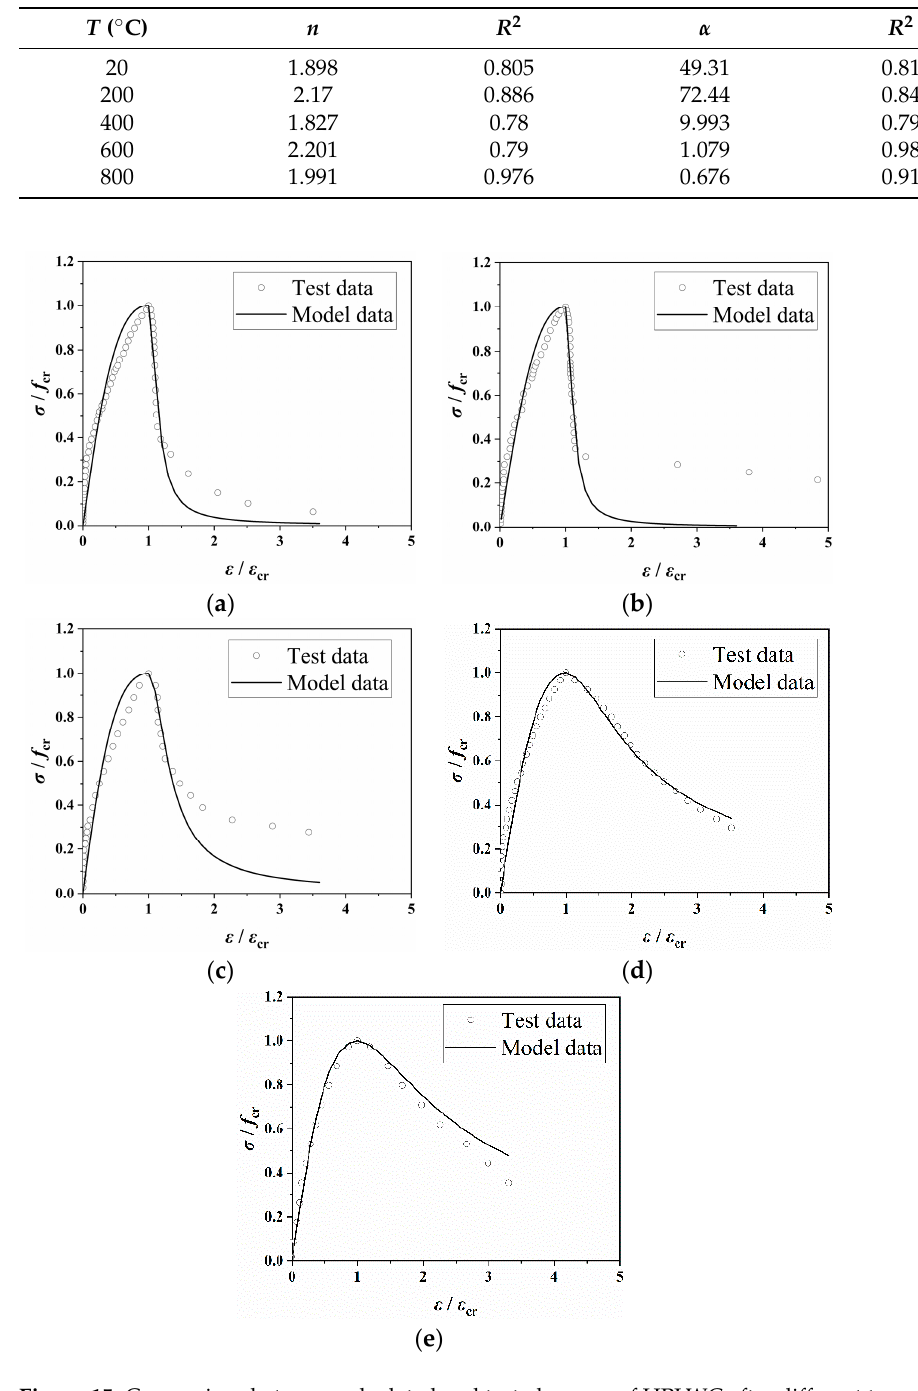
Table 7. Equation parameters of stress-strain curves of SAC after elevated temperatures.